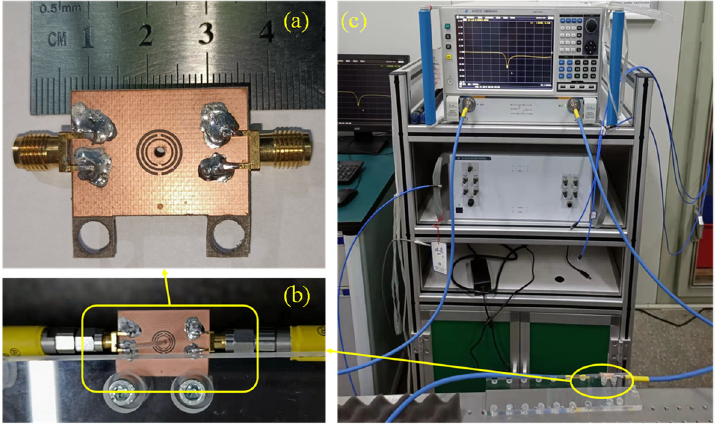
Figure 12. Experimental verification. ( a ) Top view of the CSRR; ( b ) The sensor is fixed on a PTFE plate; ( c ) Experimental set up.